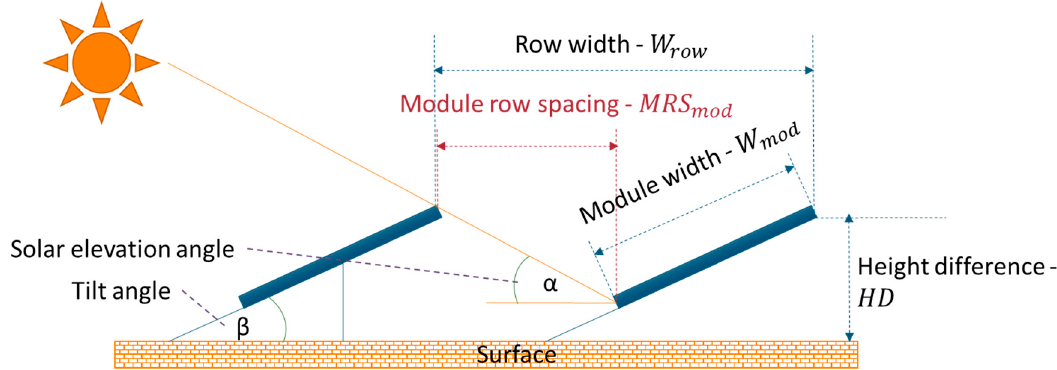
Figure 3. Schematic of two simulated photovoltaic rows at solar noon. Reproduced with permission from the authors of “Submerged and Floating Photovoltaic Systems”, Copyright Elsevier Science Publishing Co Inc., 2018 [33].